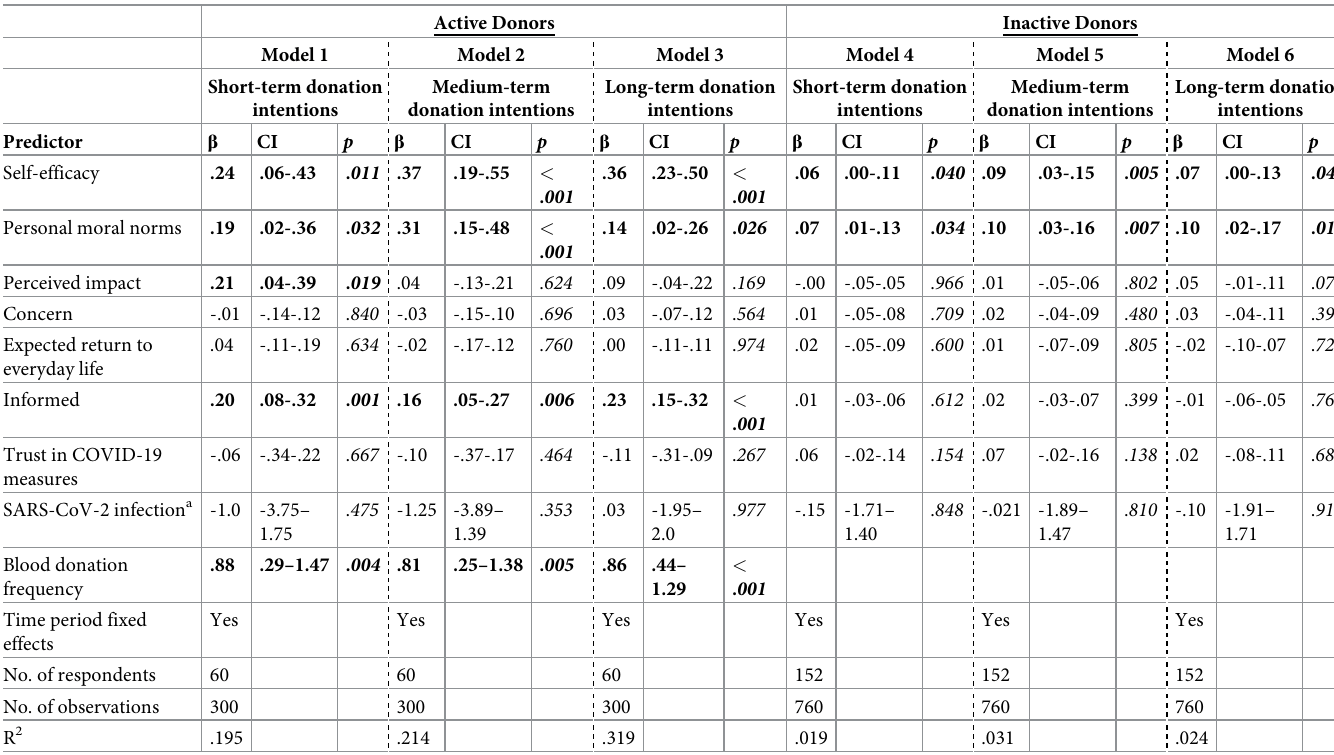
Table 3. Panel regression analysis for active and inactive